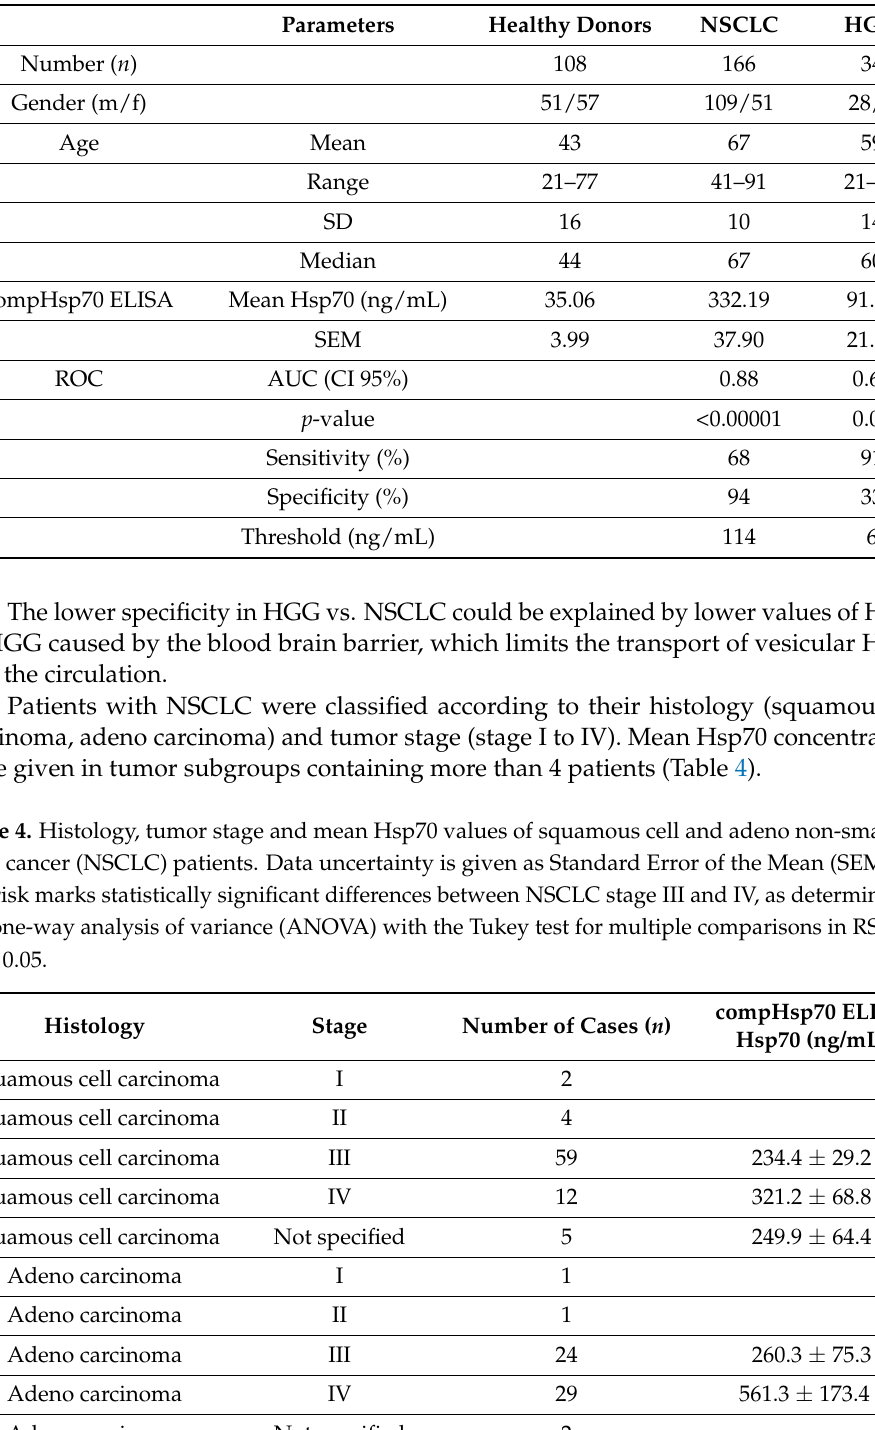
Table 3. Characteristics and mean Hsp70 concentrations of healthy donors and patients with NSCLC and HGG. Used abbreviations in the Table: Area Under the Curve (AUC); Male (M); Female (F); Confidence Interval (CI); high grade glioma (HGG); Non-small cell lung cancer (NSCLC); Receiver Operating Characteristic (ROC); Standard Deviation (SD); Standard Error of the Mean (SEM). A two-sided t -test was used.